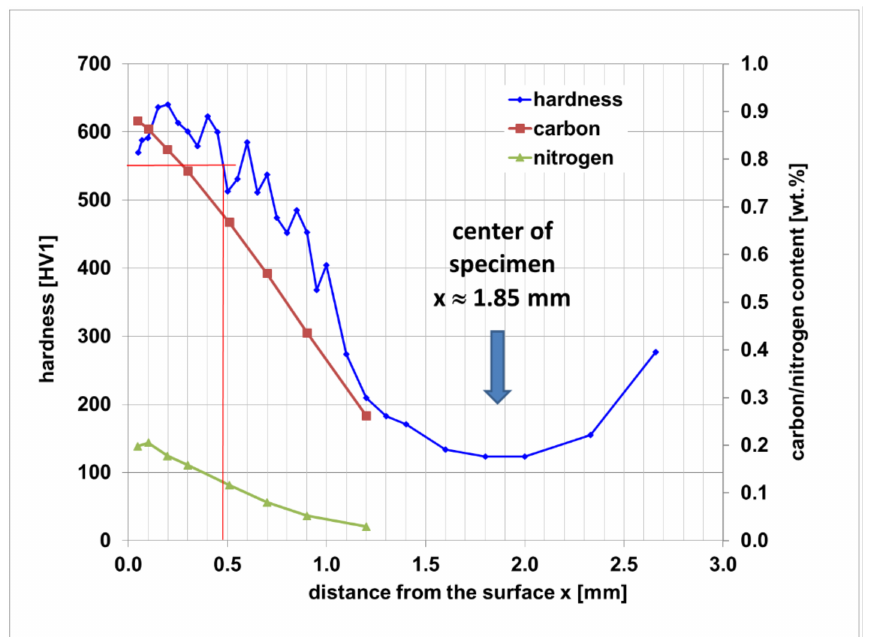
Figure 9. Hardness (HV1), carbon, and nitrogen content profile of a carbonitrided sample without hollow